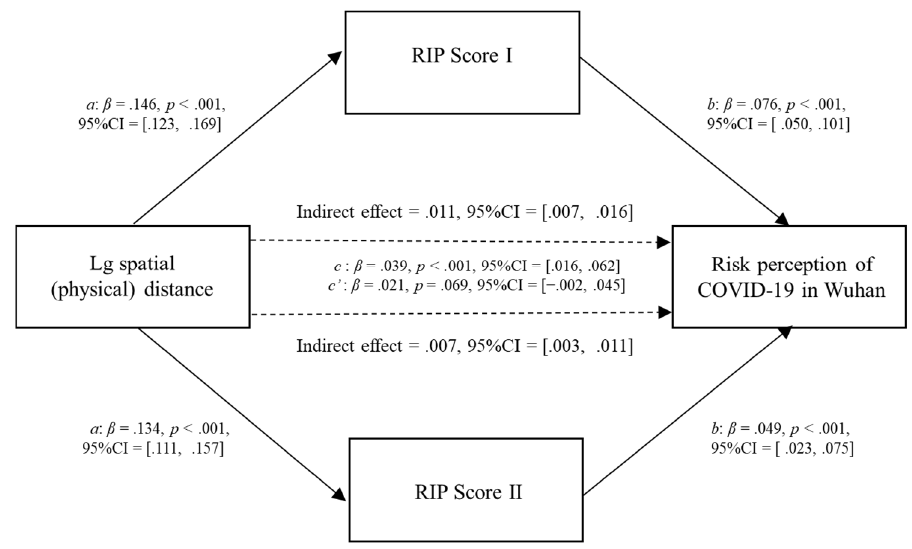
Figure 7. Parallel mediation model showing the effects of spatial (physical) distance and risk infor- mation proportion on the risk perception of COVID-19 in Wuhan; N = 7283.